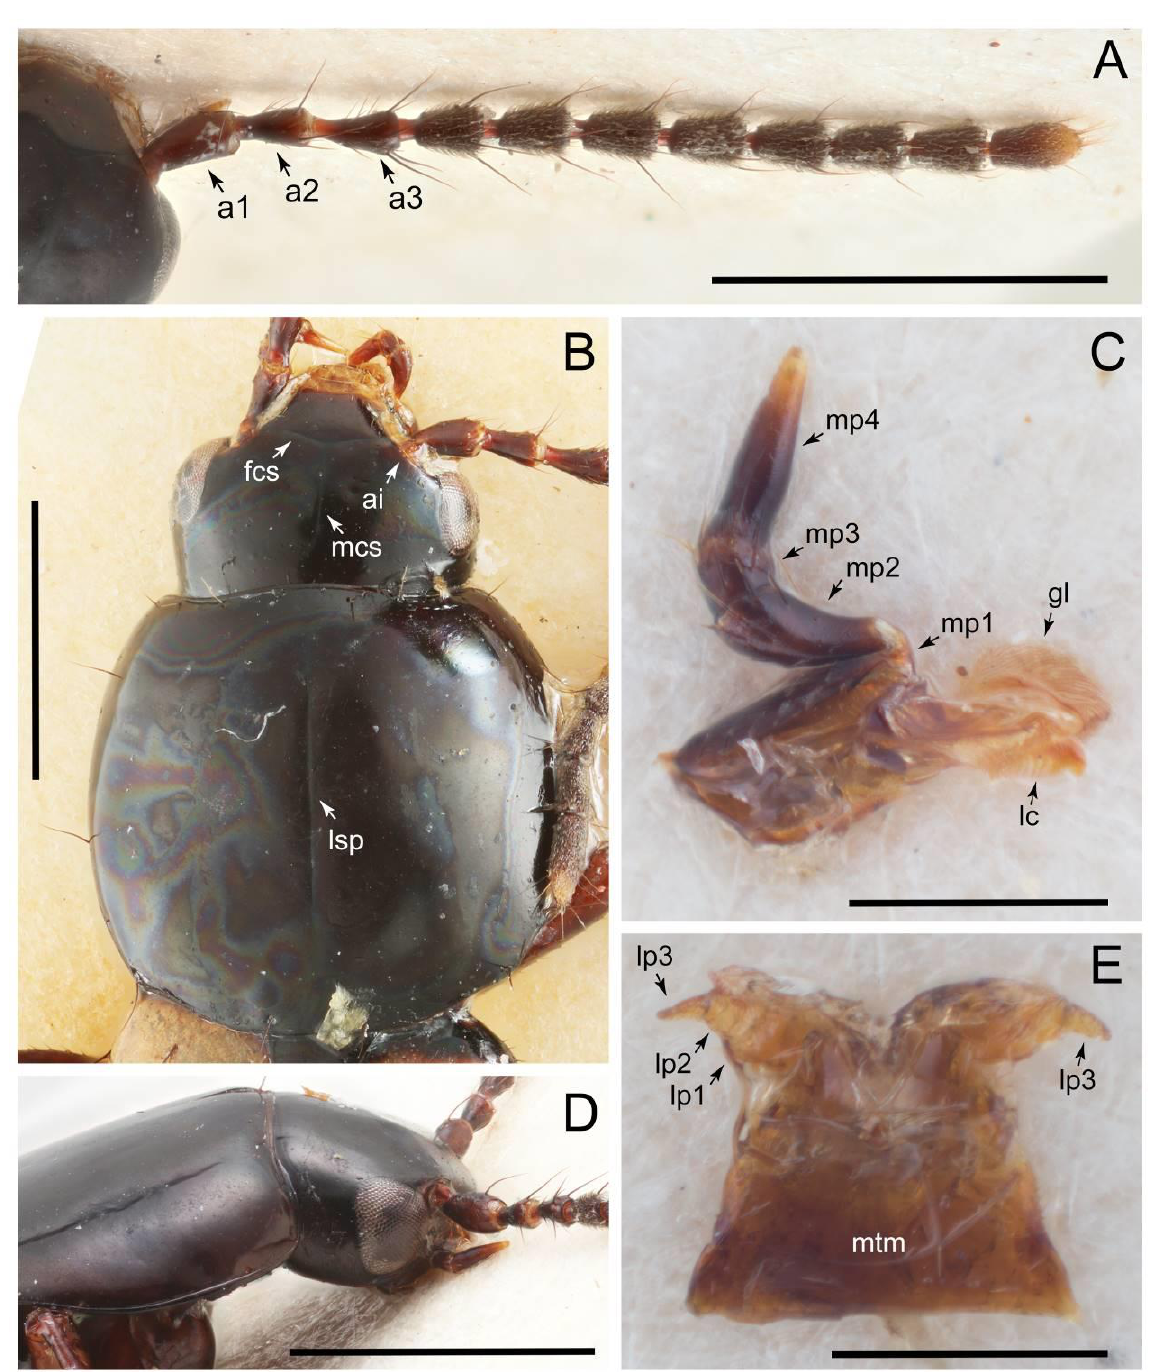
Figure 37. Photographs of Vatesini ( Tachinoporus basalis ). ( A ) right antenna of the syntype, dorsal view. ( B ) forebody, male, dorsal view. ( C ) right maxilla of the syntype, ventral view. ( D ) head and pronotum of the syntype, dorsolateral view. ( E ) labium and mentum of the syntype, ventral view. Scale bars: 1.0 mm ( A , B , D ); 0.3 mm ( C , E ). Abbreviations: a1–3, antennomere 1–3; ai, antennal insertion; fcs, frontoclypeal suture; gl, galea; lc, lacinia; lp1–3, labial palpomere 1–3; lsp, longitudinal sulcus on pronotum; mcs, midcranial suture; mp1–4, maxillary palpomere 1–4; mtm,